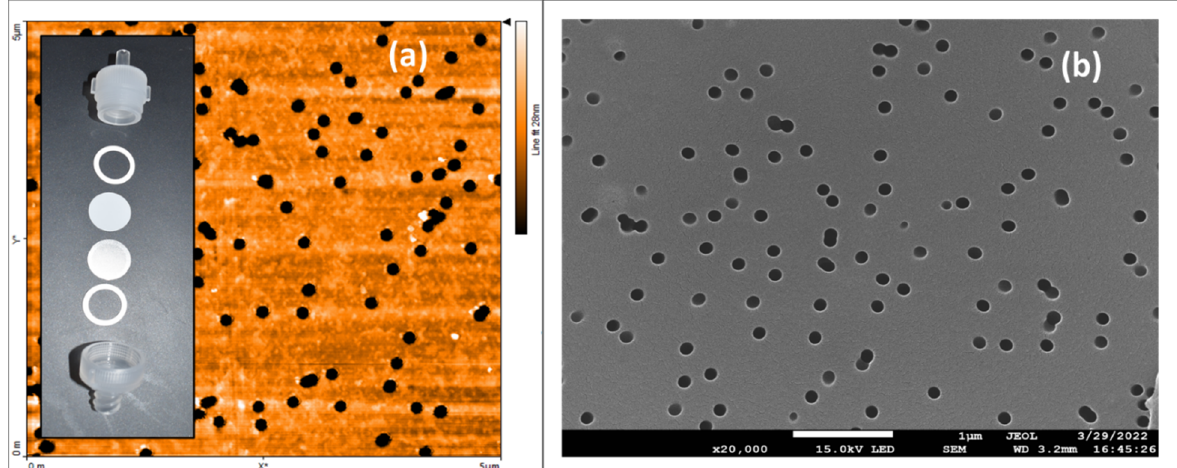
Figure 2. ( a ) Atomic force microscopy (AFM) image and ( b ) scanning electron microscopy (SEM) image of an unmodified polycarbonate filter. The color scale bar on the right of the AFM shows that the range in color from black to white spans only 28 nm. The polycarbonate filter in ( b ) was coated with a thin gold palladium coating for ease of SEM imaging. Inset: from top to bottom—the top end of a polypropylene housing with male Luer slip, silicon gasket, polycarbonate filter, photoetched stainless-steel screen, silicon gasket, and bottom end of polypropylene housing.